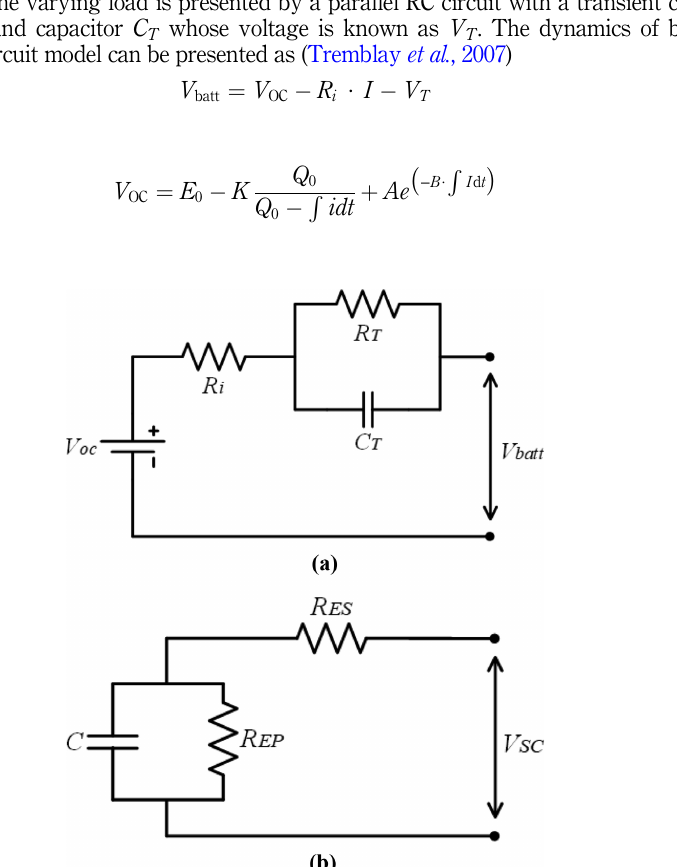
Figure 2. Equivalent circuit of (a) battery, and (b)